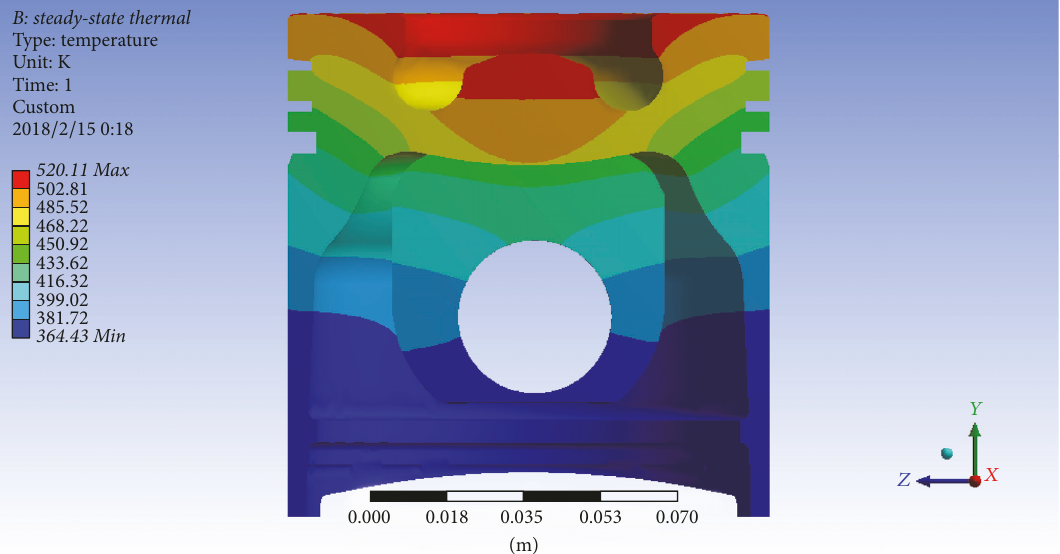
Figure 20: Distribution nephogram of the piston